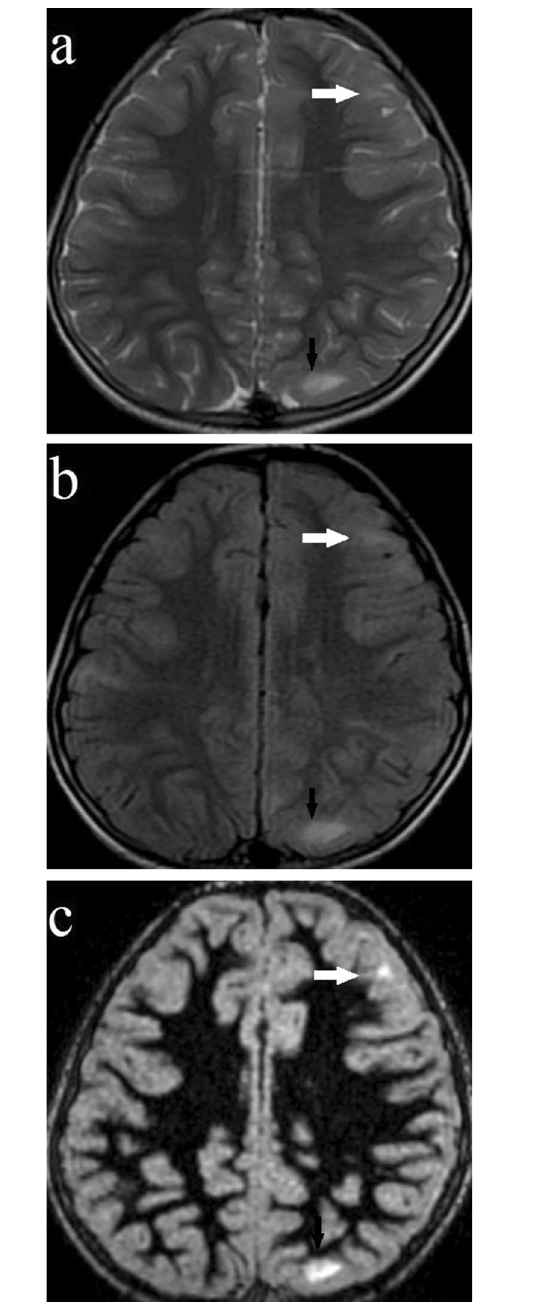
Fig. 5 Tuberous Sclerosis in an 8 years old female patient. Axial T2 ( a ), FLAIR ( b ) and DIR ( c ). A sub-cortical tuber in the left frontal lobe shows very subtle hyperintense signal in T2 and FLAIR (white arrows in a , b ) while extreme high signal is noted on DIR (white arrow in c ). Another sub-cortical tuber is seen left posterior parietal lobe (black arrows in a – c